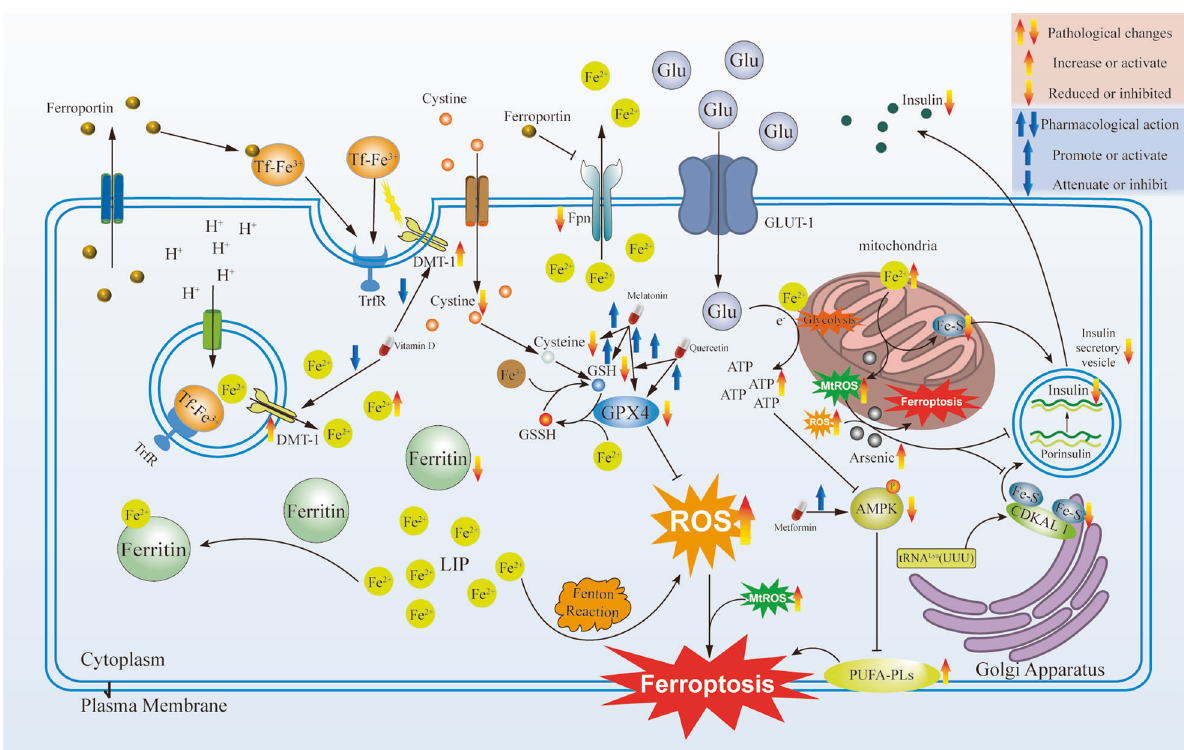
Fig. 3 Pharmacological target for treating ferroptosis in pancreatic β cells. Ferroptosis in pancreatic β cells and pharmacological target mechanisms of different drugs. Pancreatic β cells express low levels of antioxidant enzymes, such as superoxide dismutase (SOD), glutathione (GSH) peroxidase, and glutathione peroxidase 4 (Gpx4). The Fe2 + in the labile iron pool (LIP) promotes reactive oxygen species synthesis through the Fenton reaction, leading to the accumulation of reactive oxygen species (ROS). External factors will cause mitochondria